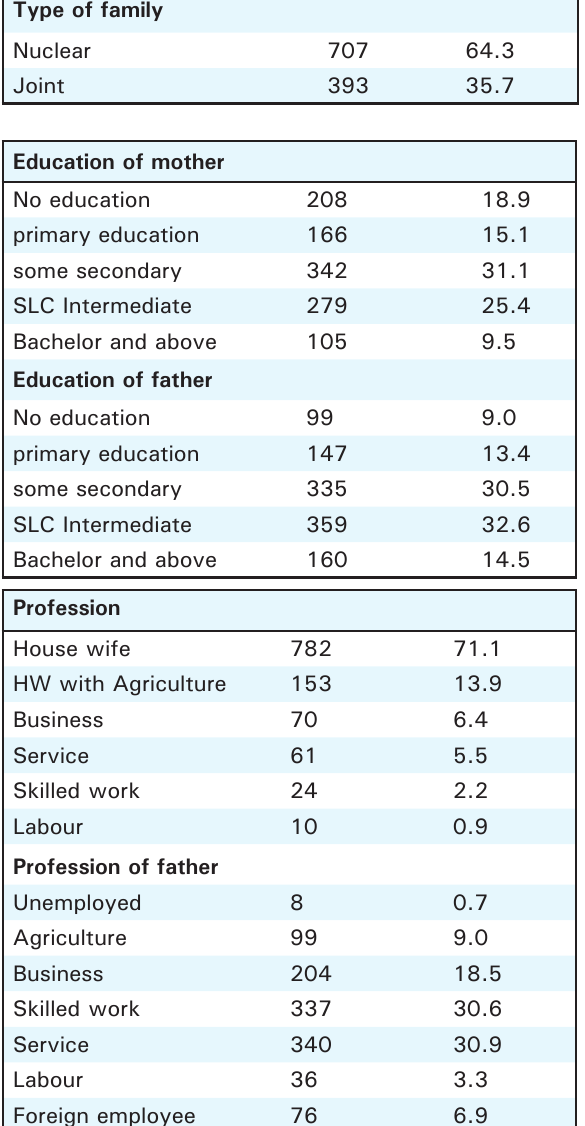
Table1. Socio-demographic Characteristics of respondents.